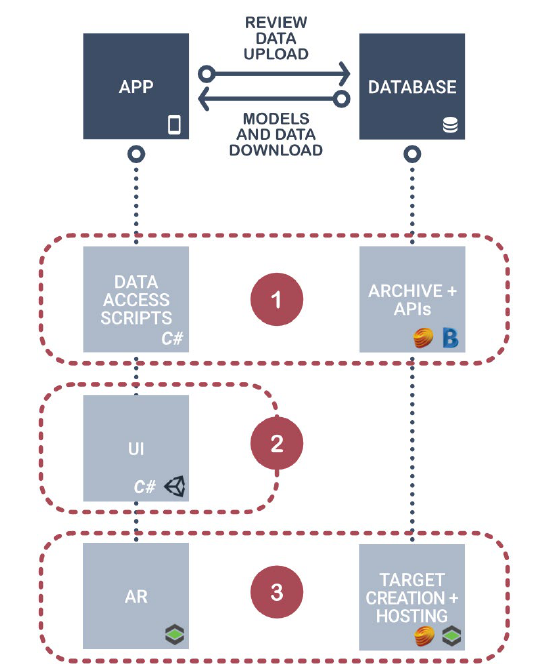
Figure 2. Scheme of the main components of the developed system: (1) server-client API communication; (2) user interface on the app side; (3) AR model archive and AR visualization